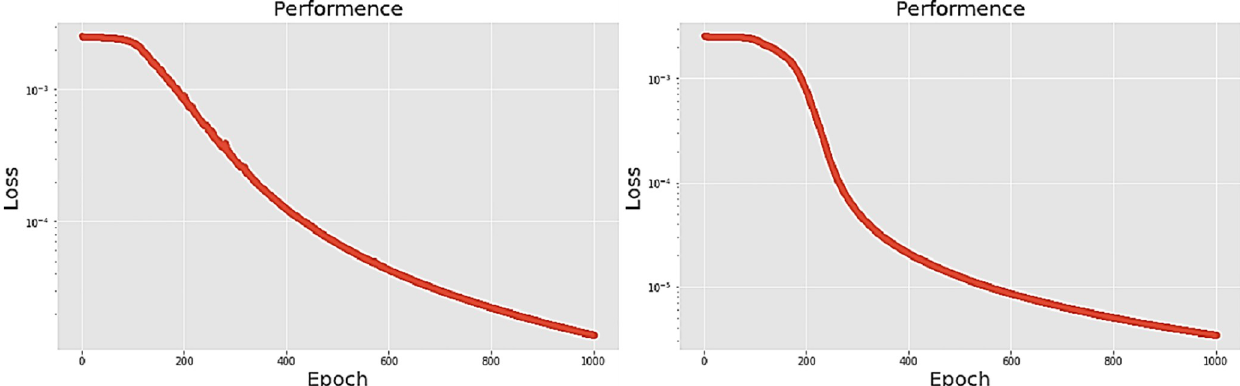
Fig 24. (a) The graph shows the performance of LPC-LSTM-2 × 700 model; (b) The graph shows the performance of LPC-PCA-LSTM-2 × 700 model.